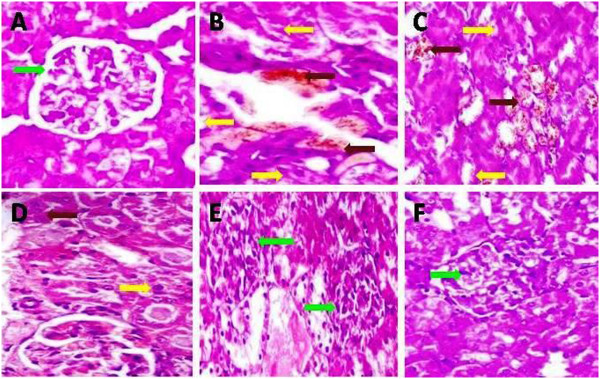
Paederia Foetida Linn. leaves extract effect on kidney histopathology in normal and STZ induced diabetic rats. (A) Normal control: Bowman capsule in average size (B) Diabetic control: Diabetic control group rat histopathology display inflammatory cells in blood vessels (Red arrow) and fat deposition (Yellow arrow). (C)PF I (100 mg/kg): PF treated group display inflammatory cell in blood vessels (Red arrow) and deposition of fat (Yellow arrow). (D)PF II (250 mg/kg): PF tested drug group histopathology few parts display the fat deposition (Yellow arrow) and inflamed cells in blood vessels (Red arrow). (E)PF III (500 mg/kg): PF treated drug display the normal histopathology few changes in the size of bowman capsules. (F) Glibenclamide (10 mg/kg): Glibenclamide treated group rat did not display any changes in the histopathology, only bigger size of bowman capsules. The samples were obtained from the same liver anatomical regions. For each group, 6 rats were examined and 80 pictures were taken. Original magnification, 40×.